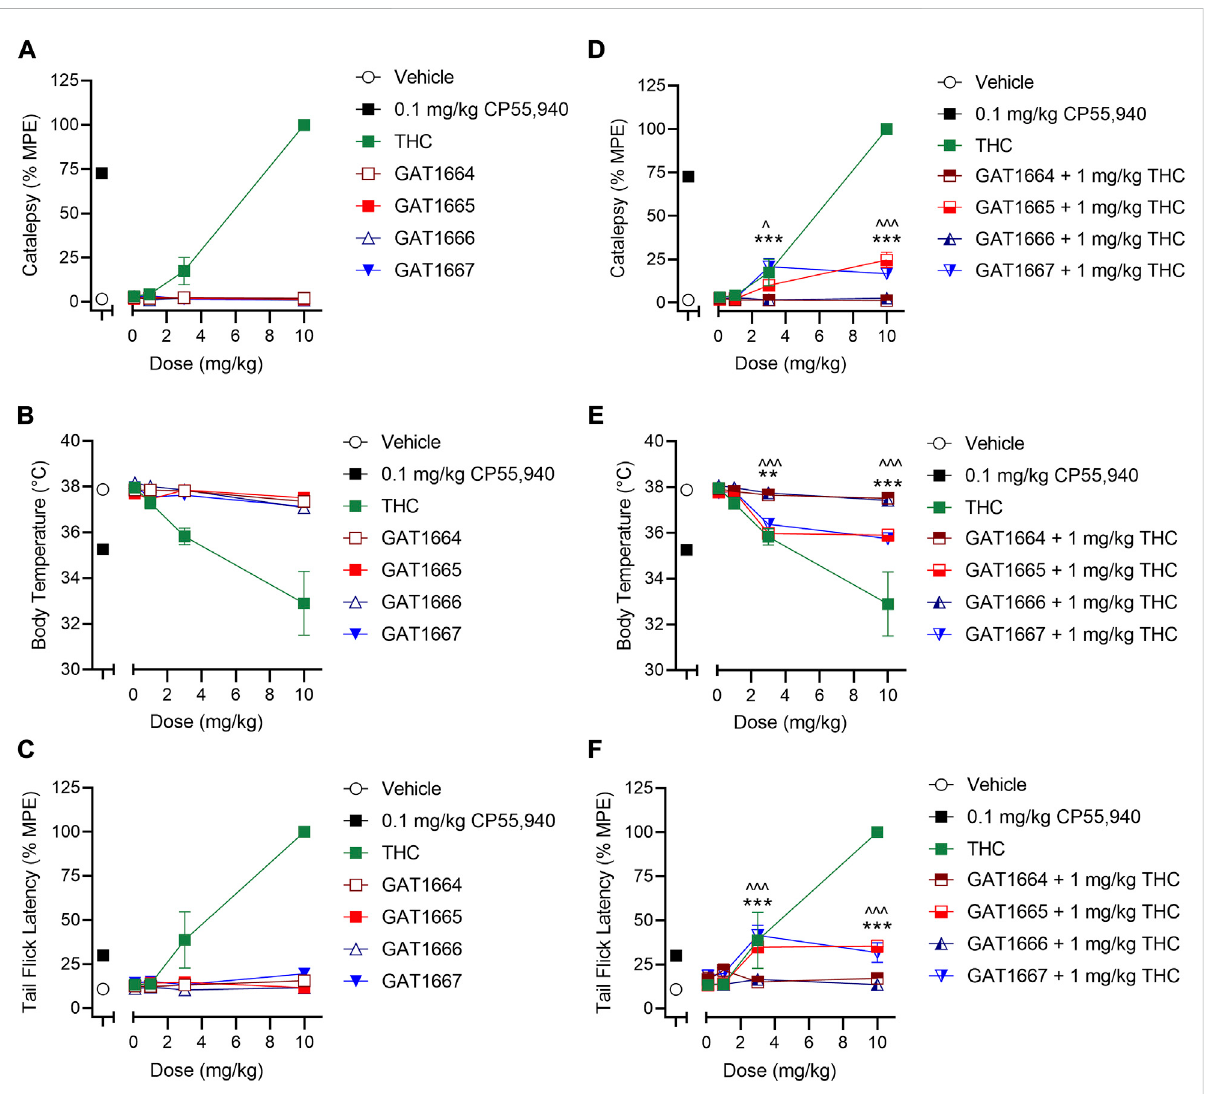
FIGURE 5 Invivo effectsofGAT1664,GAT1665,GAT1666andGAT1667inmaleC57BL/6mice.C57BL/6micewereadministeredcompoundseitheralone or co-administered with 1 mg/kg THC to assess catalepsy, hypothermia and nociception. Doses used were 0.1 – 10 mg/kg compound or volume- matchedvehiclecontrol(1:1:18 ethanol/cremaphor/saline) andassessmentofcatalepsy (%MPE60 s) (A,D) ,bodytemperature (B,E) ,andnociception in the tail fl ick assay (%MPE, 20 s) (C,F) were performed; n = 5 – 10/group; data are mean ± SEM. ^ p < 0.05, ^^^ p < 0.001 for GAT1665 compared to 1 mg/kgTHC;** p < 0.01,*** p < 0.001forGAT1667comparedto1 mg/kgTHCasdeterminedbytwo-wayANOVAfollowedbyBonferroni ’ s post-hoc